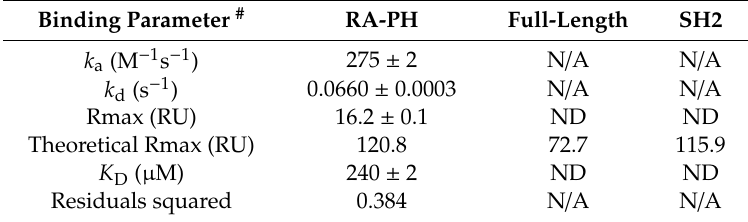
# Binding parameters calculated from fits to a single site binding model. The errors shown are the error arising from the fits. CaM was injected at 8 concentrations with each concentration tested in duplicate. Experiments